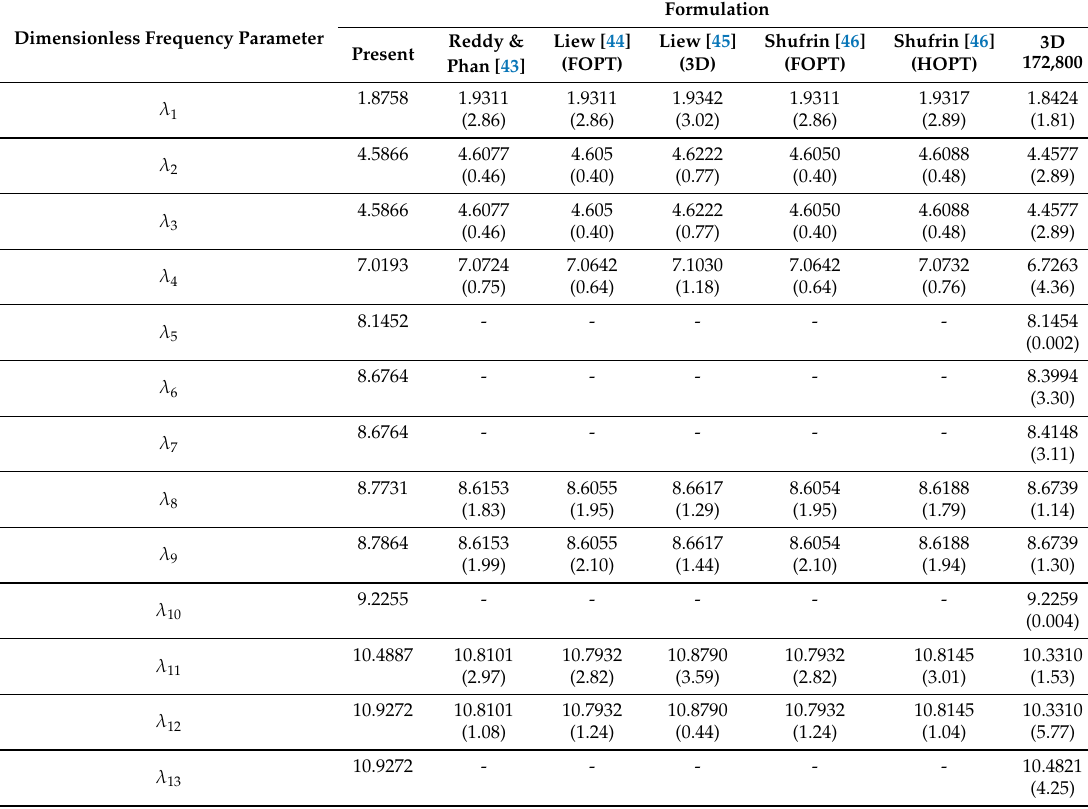
Dimensionless Frequency Parameter